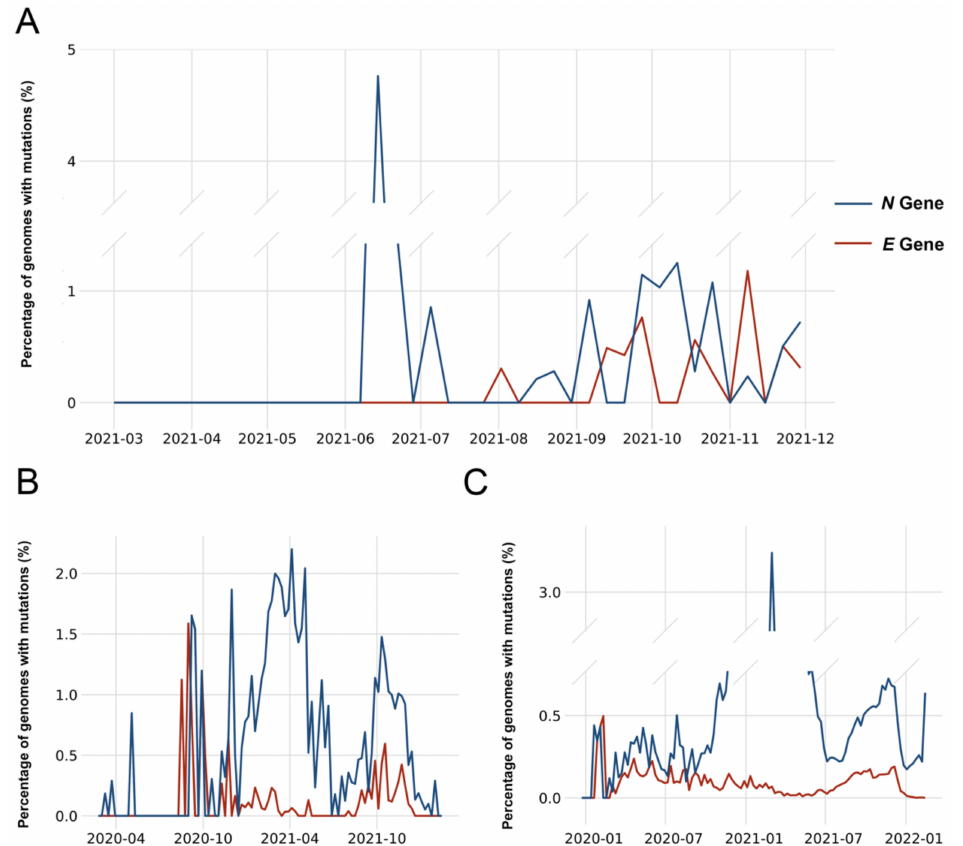
Figure 1. Trends of significant mutations in the genome over time. The graph shows the proportion of isolates containing significant mutations in the primers and probes of the E gene amplicon (red) and N gene amplicon (blue). (( A ), n = 7586) The changes in the local New York City communities are depicted from March 2020–December 2020, (( B ), n = 118,913) New York State April 2020–December 2021, and (( C ), n = 7,771,134) whole world January 2020–January